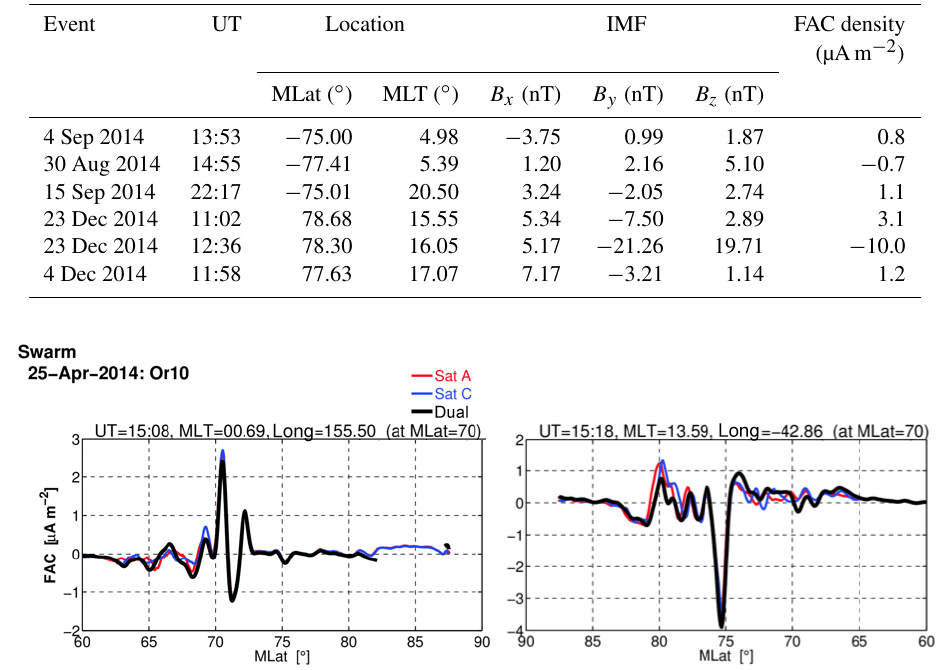
Table 1. Summary of locations and IMF conditions during the high-latitude FAC events.